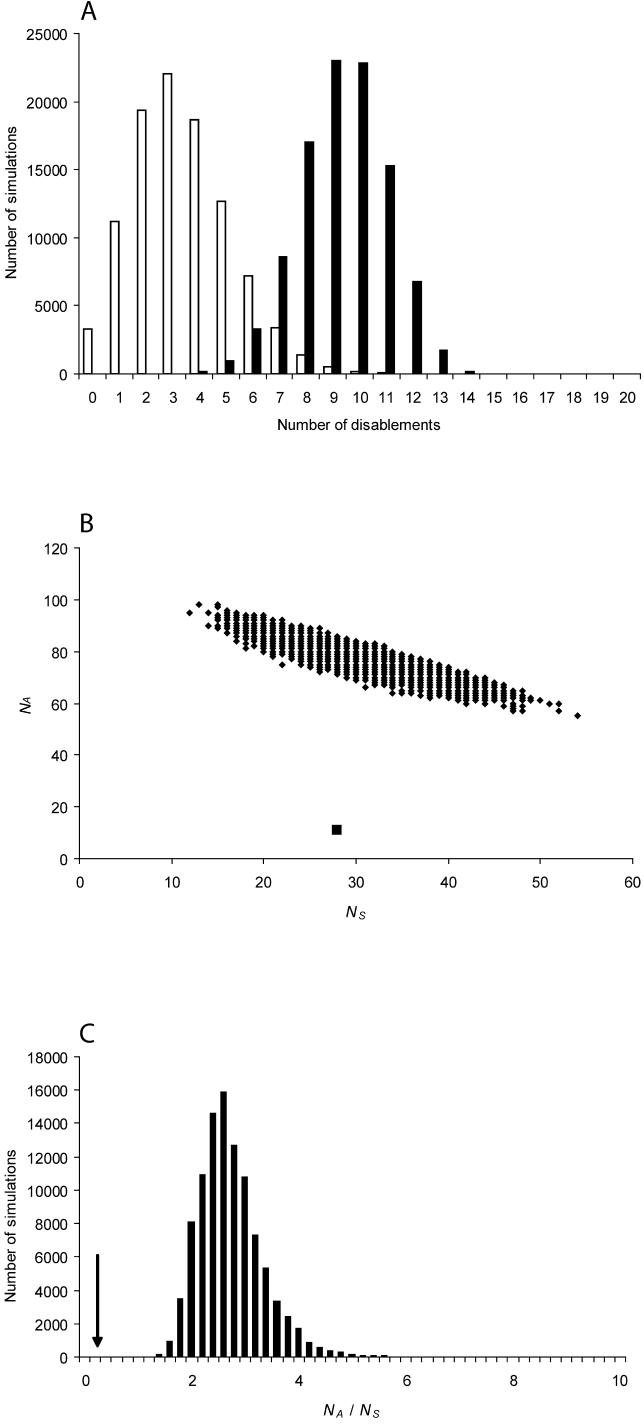
Illustration of the Simulation Results Used to Support Functionality of Retrogenes for One Case (RBMXL1)
(A) Distribution of the number of disablements observed in 105 simulations of the RBMXL1 retrogene evolution under neutrality. The frequency distribution of stop codons is shown in white, and that of deleterious indels in black. All of the simulations showed at least one mutation disrupting the ORF (see text); simulations without stop codons all showed several frame-disrupting indels (the minimum number of such indels in each simulation is four).(B) Nonsynonymous (N
A) and synonymous (N
S) substitutions observed in 105 simulations of neutral RBMXL1 retrogene evolution (diamonds). The black square indicates the observed nonsynonymous and synonymous substitutions in the RBMXL1 primate phylogeny.(C) Ratio of nonsynonymous to synonymous substitutions in 105 simulations of RBMXL1 retrogene evolution in the primate lineages. The arrow indicates the observed ratio of nonsynonymous to synonymous substitutions in the RBMXL1 primate phylogeny.